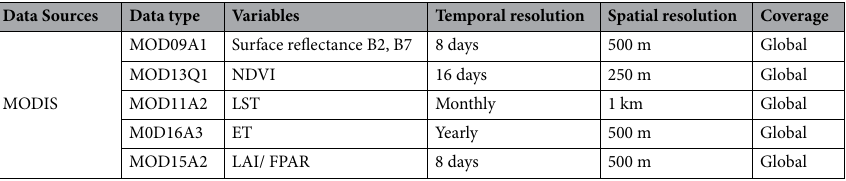
Table 4. Detailed specifications of the remote sensing datasets.